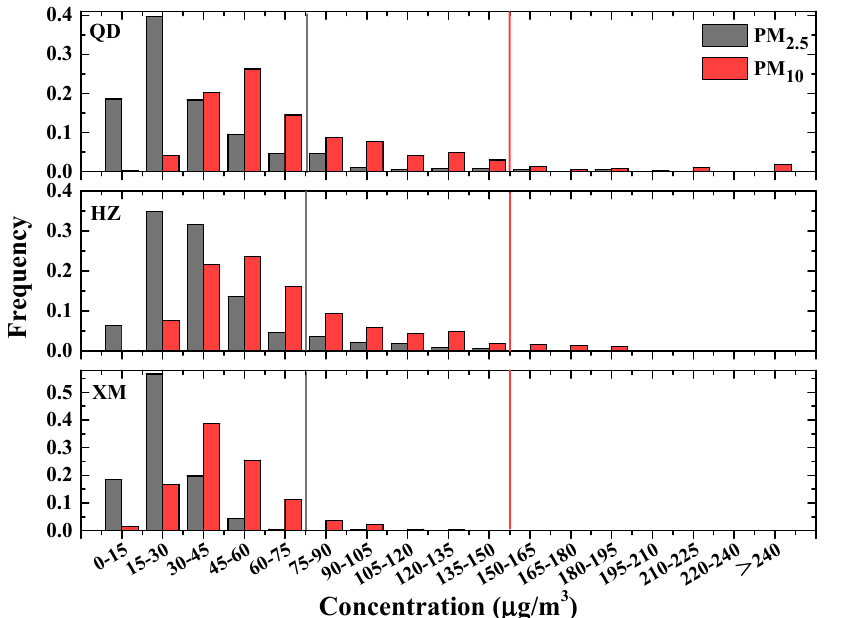
Figure 4. Frequency distributions of daily PM 2.5 and PM 10 in Qingdao (QD), Hangzhou (HZ) and Xiamen (XM) during 2018. The CAAQS Grade II of daily average for PM 2.5 and PM 10 are plotted as solid lines.